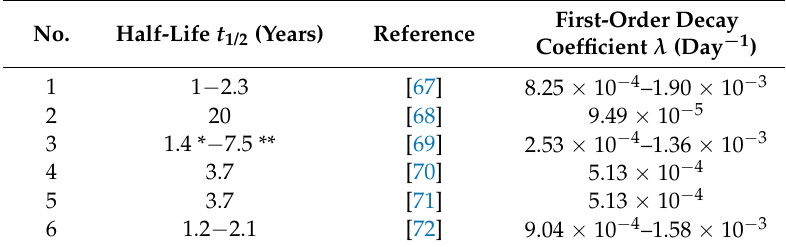
Table 2. Half-life of nitrates and calculated first order decay